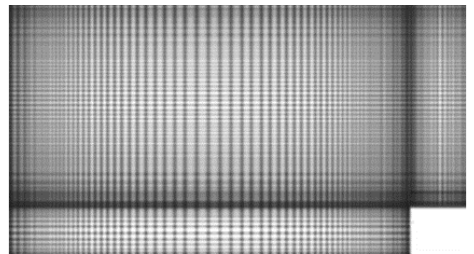
Figure 2. Computational mesh “medium” (not to scale).